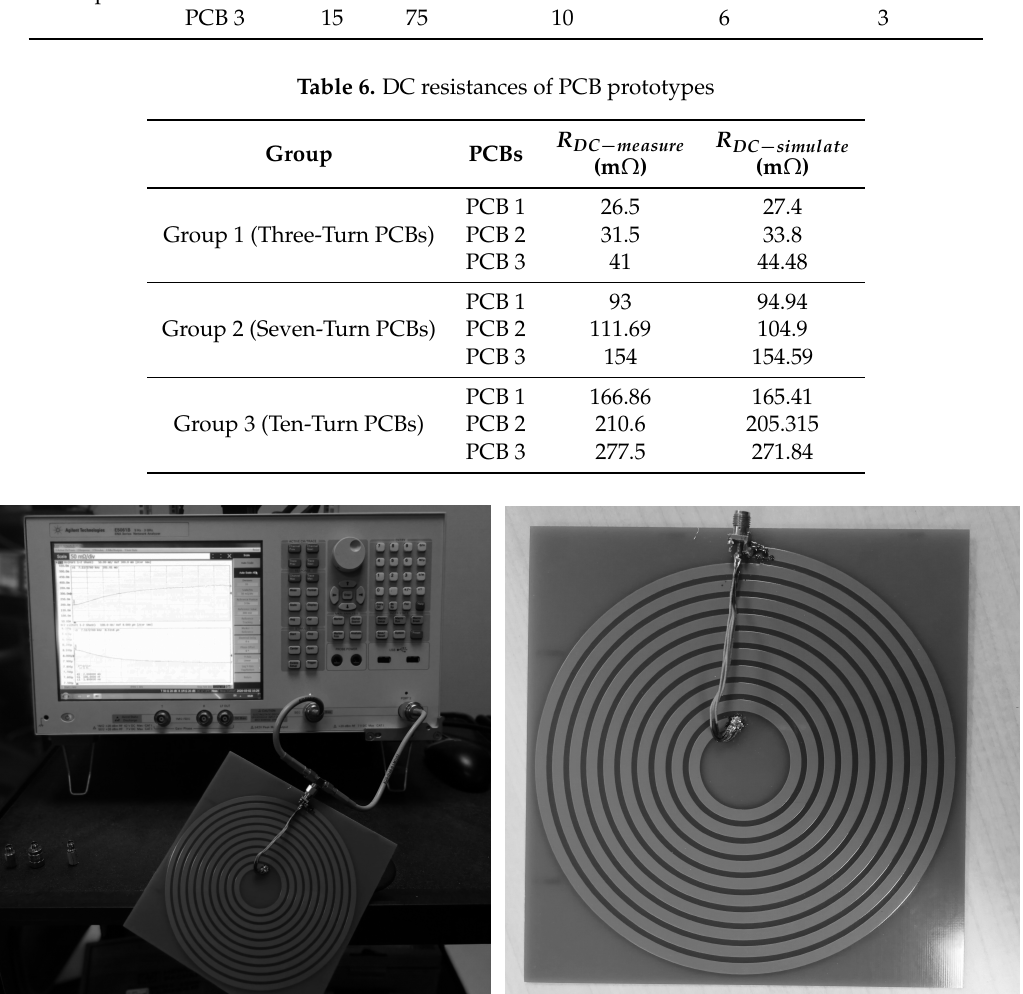
Figure 13. The set up of VNA ( left ) and a ten-turn spiral winding ( right